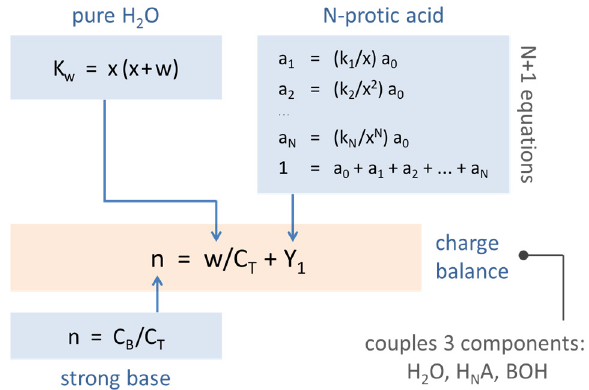
Figure 9. Set of equations describing the 3-component acid–base system (H 2 O, H N A, strong base). The three components are coupled via the charge-balance equation.